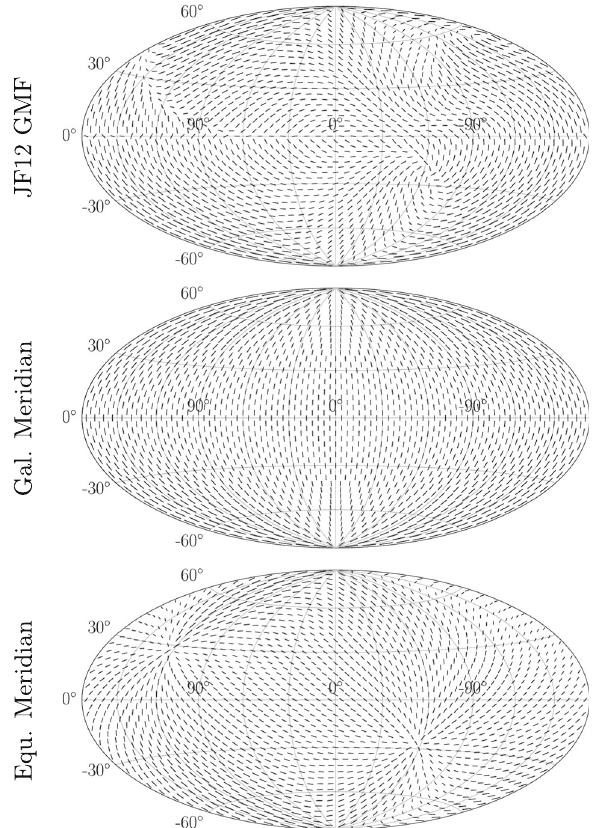
Fig. 2 Visualization of the utilized tangent vector fields ˆ u 0 in the Galactic coordinate system. (Top) Local orientation of deflection pat- terns from simulations in the JF12 field calculated by the displacement of an R = 10 20 eV particle. (Middle) Meridians in Galactic coordi- nates along the local ˆ e ϑ unit vector. (Bottom) Meridians in Equatorial